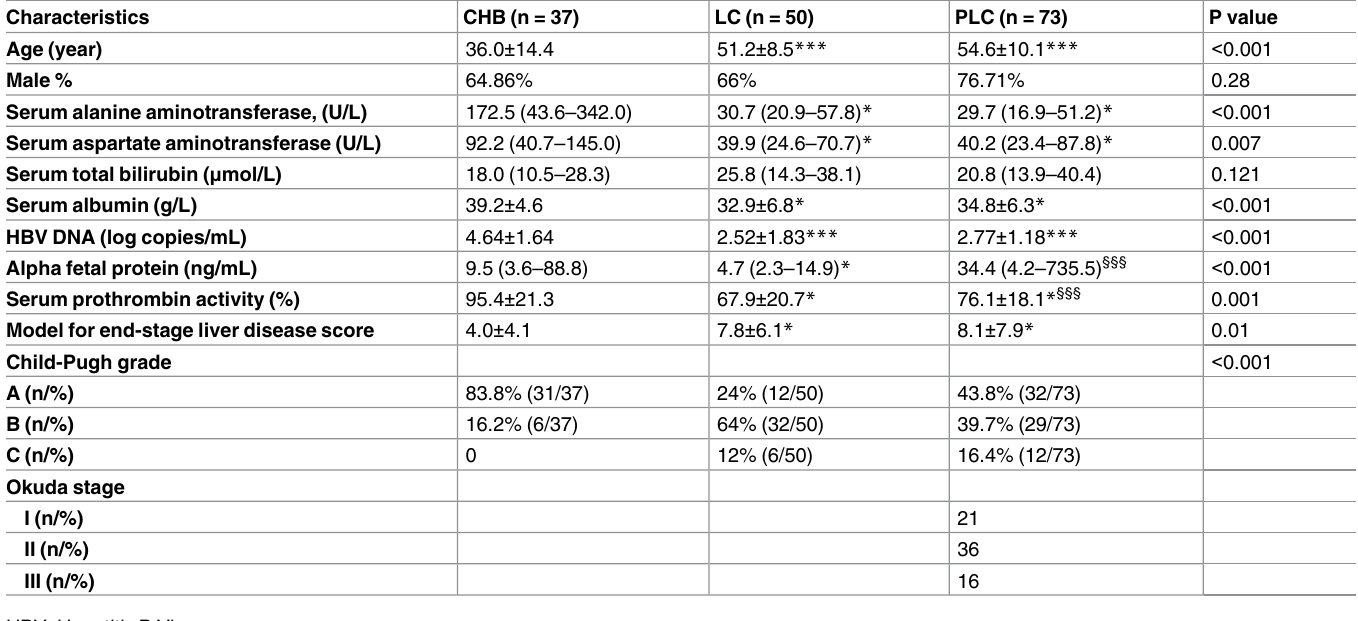
Table 1. Patient basic